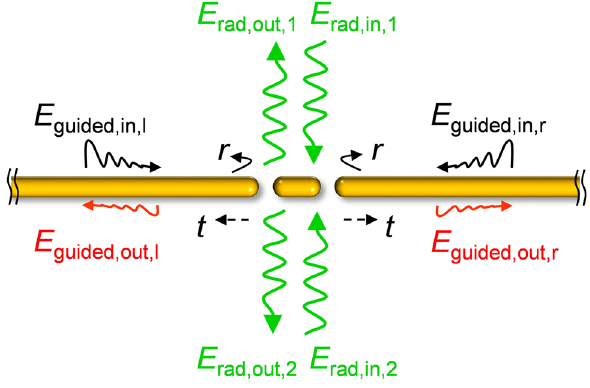
Figure 1: Sketch of a symmetric wire – rod – wire system. In general, guidedsurfaceplasmons E guided aswellasradiativemodes E rad have to beused as incomingand outgoing modes.Within the generalized CPA formalism in this work, only the subset of guided surface plasmons is considered as incoming